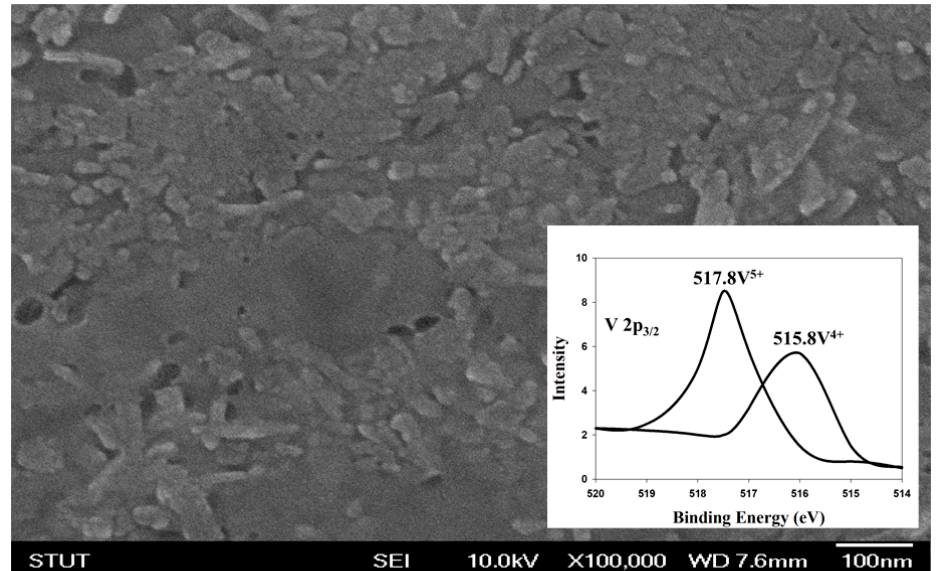
Figure 1. The micro-structure of the vanadium oxide thin films from the SEM surface morphology and XPS results.